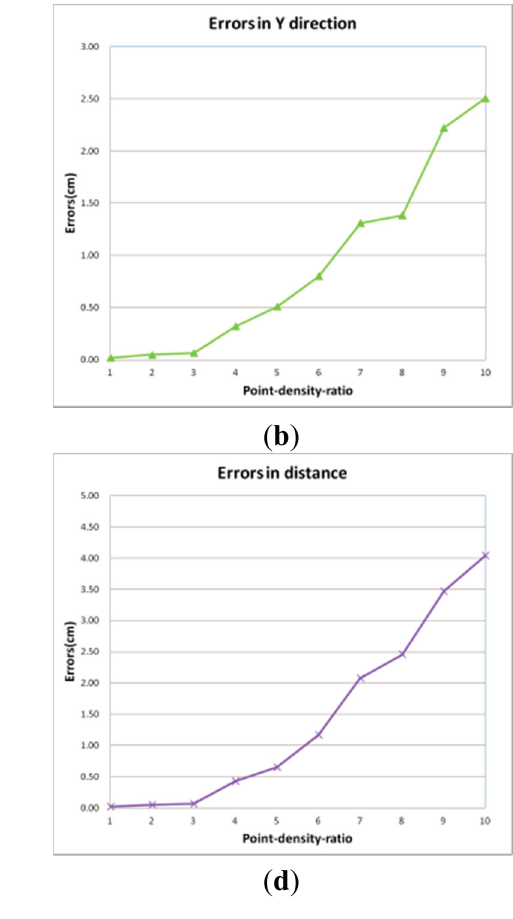
Figure 6. Simulation results: ( a ) Position difference along X-axis. ( b ) Position difference along Y-axis. ( c ) Position difference along Z-axis. ( d ) Distance between transformed point and original